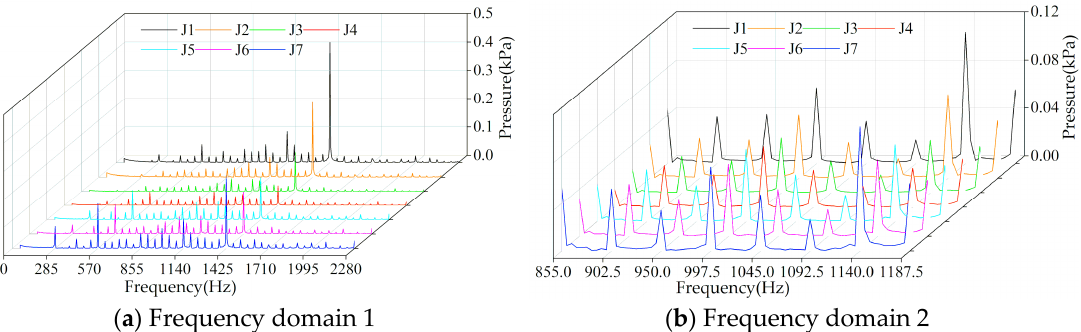
Figure 23. Frequency domain diagrams of pressure fluctuation for monitoring points in the ejector.